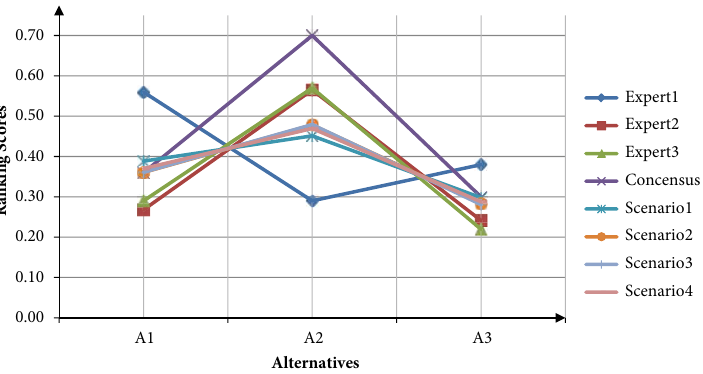
Fig. 3. Rankings of alternatives obtained by Fuzzy AHP with respect to expert preferences and weighting